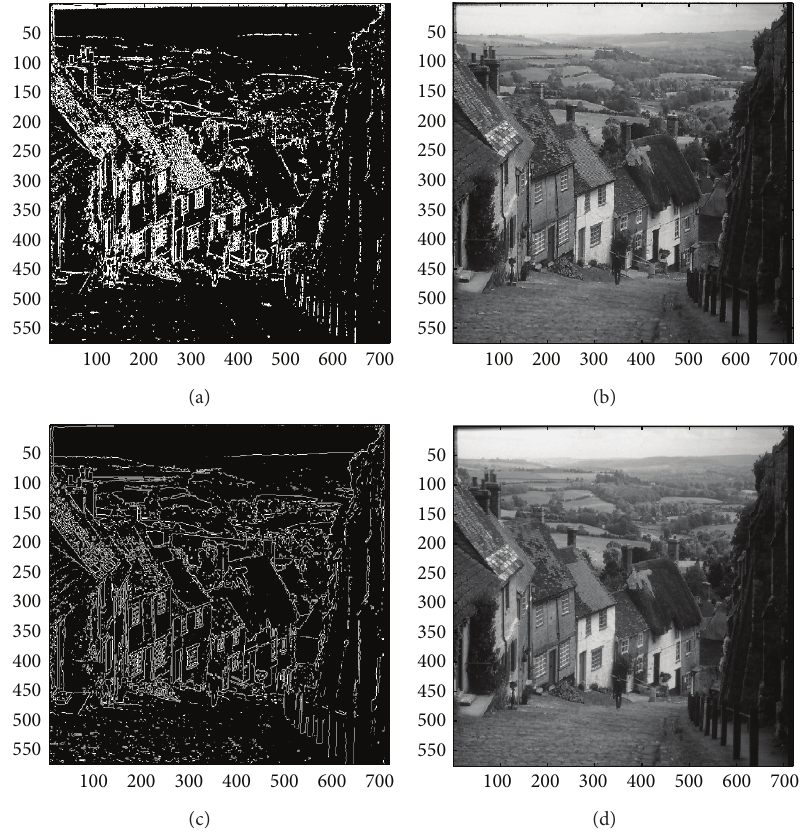
= 14 in the image “Goldhill.” (b) Result by HVD with scaling factor 𝑠 = 1.0 . (c) Edges detected Figure 7: (a) Edges detected by HVD with 𝜃 eth by Canny operator in the image “Goldhill.” (d) Result by Canny operator with scaling factor 𝑠 = 1.0 .